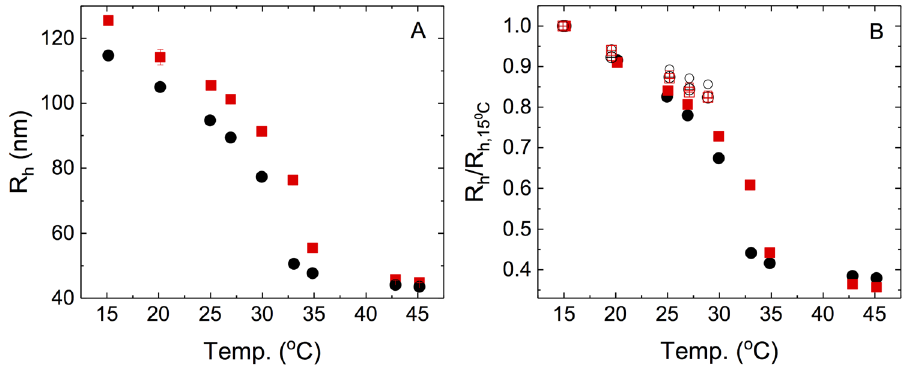
Figure 1. Swelling behavior of microgels. Temperature dependence of the hydrodynamic radius R h for the deuterated and hydrogenated particles in H 2 O. Shown are the actual values ( A ) as well as rescaled values ( B ) where the temperature-dependent values R h ( T ) are normalized by R h (15 °C) as a function of temperature for deuterated (squares) and hydrogenated (circles) particles. Also shown are the corresponding values obtained in the ZAC solvent for Hm (open black circles) and Dm (open red squares), as well as the results obtained in 12:88 H 2 O:D 2 O, (Hm: open black crossed circles, Dm: open red crossed squares). Error bars are calculated based on the standard deviation of the measurements of the decay time for the individual scattering angles,